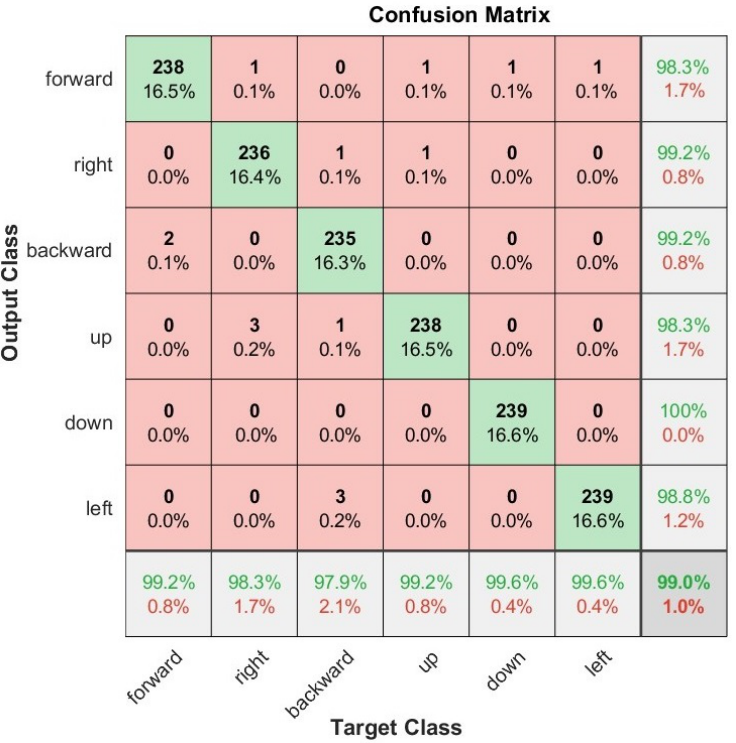
Figure 7. User-specific HGR model confusion matrix for 16 users from the test set with the best hyperparameter configuration for the G-force sensor for dynamic gestures.